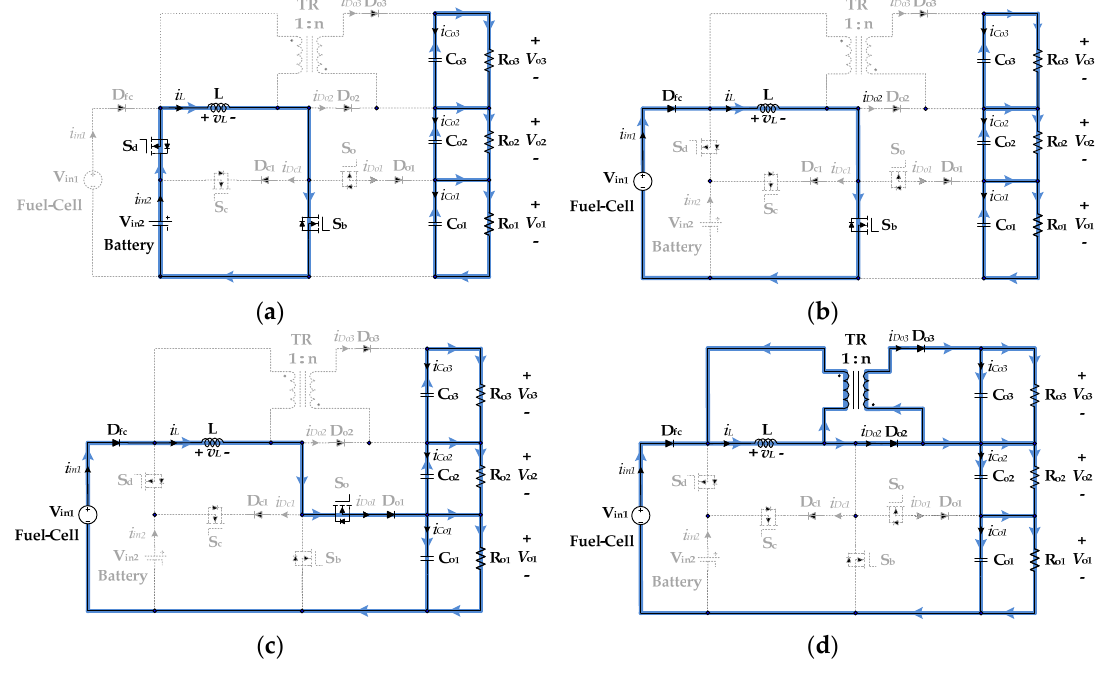
Figure 3. Equivalent circuits of the battery discharging mode: ( a ) State 1 (0 < t < D d T ); ( b ) State 2 ( D d T < t < D b T ); ( c ) State 3 ( D b T < t < D o T ); and ( d ) State 4 ( D o T < t < T